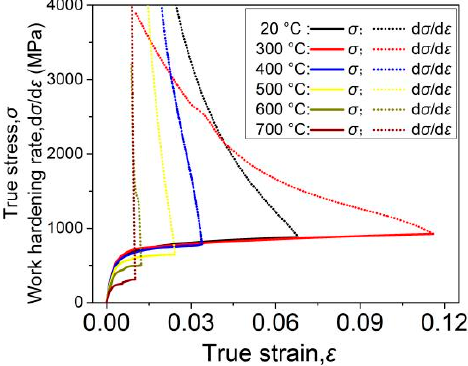
Figure 10. True stress-true strain curves and work-hardening rate curves at different temperatures.